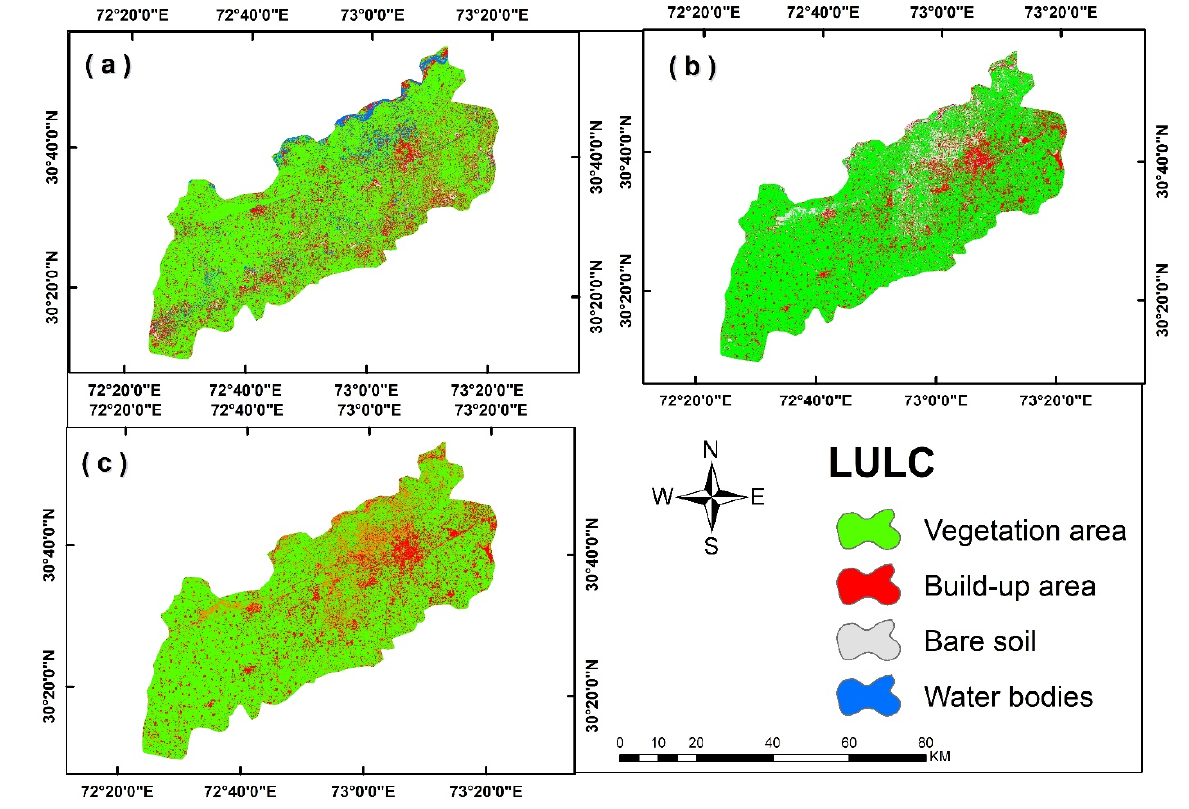
Figure 5. LULC maps for the years ( a ) 1981, ( b ) 2001, and ( c ) 2021 of the Sahiwal District. Table 7. Summary of producers’ and users’ accuracy and kappa (K) coefficients in Sahiwal